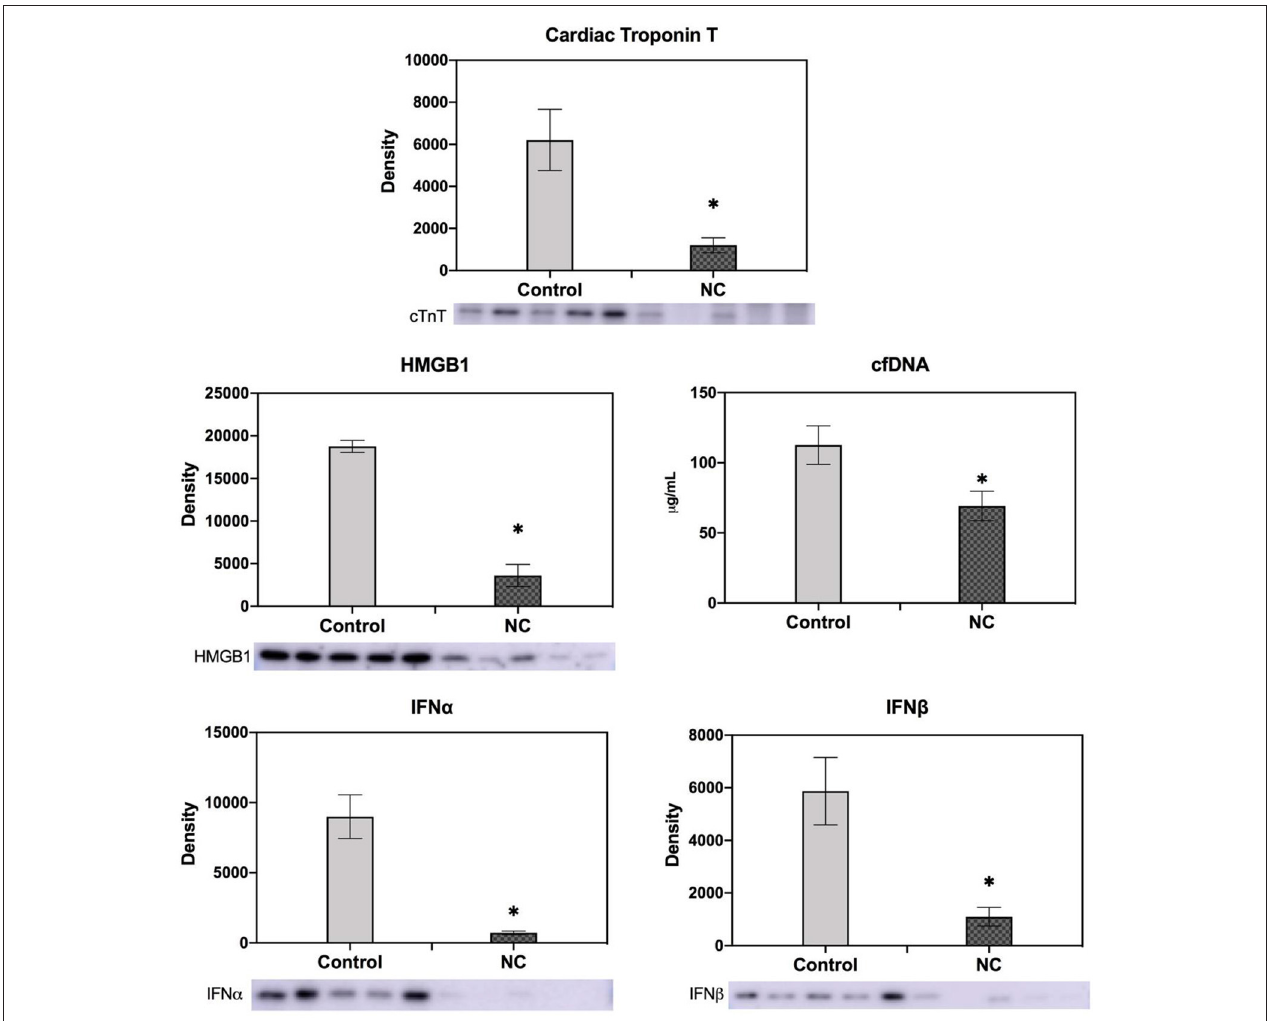
FIGURE 6 | NC decreased cardiac troponin T, HMGB1, cell-free DNA, and type I interferon (IFN α and IFN β ) levels in cardiac perfusate after ischemia. Cardiac perfusate was collected after 40min of left coronary artery occlusion without reperfusion from normothermic mice or mice that underwent NC. Levels of cfDNA were measured by Nanodrop; levels of cTnT, HMGB1, and IFN α and IFN β were measured by Western Blot. NC, topical neck cooling; cTnT, cardiac troponin T; cfDNA, cell-free DNA; * p < 0.05 vs.